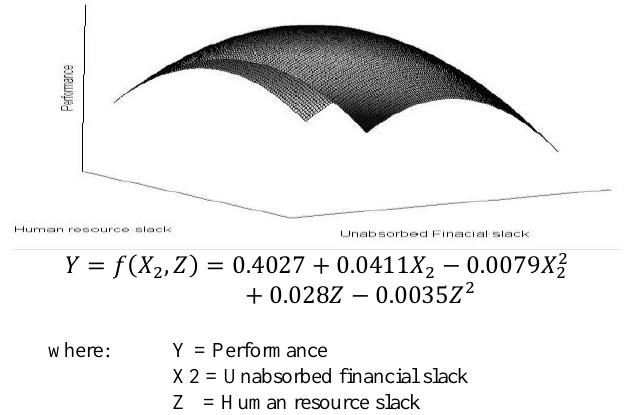
Figure 2: Curvilinear relationship between